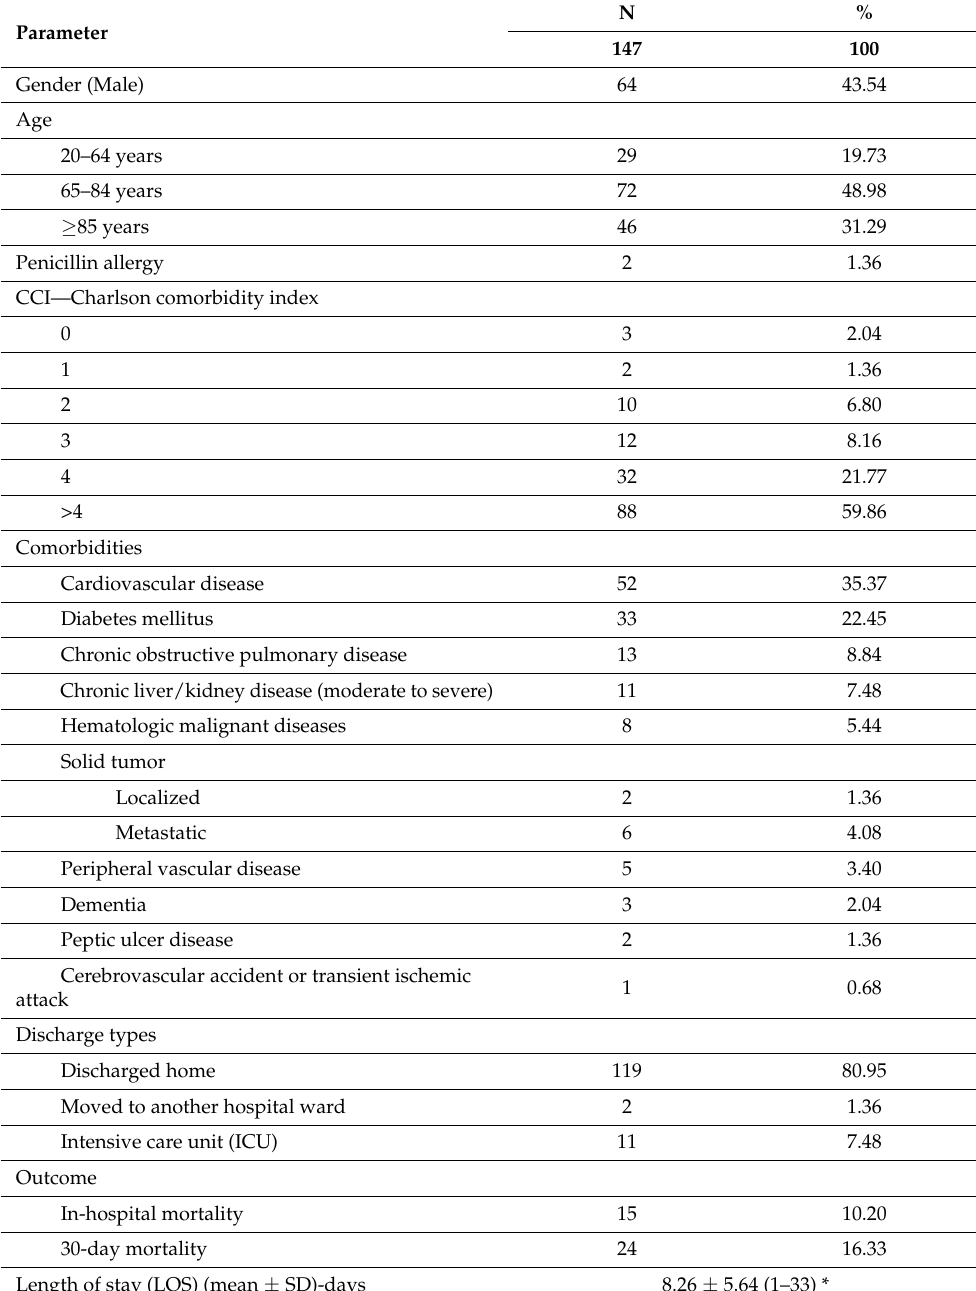
Table 1. Demographic and clinical characteristics of patients with